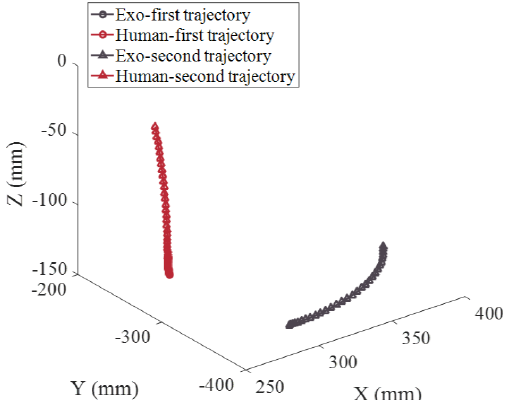
Figure 16. The trajectory of the shoulder joint of the exoskeleton and the upper limb when drinking